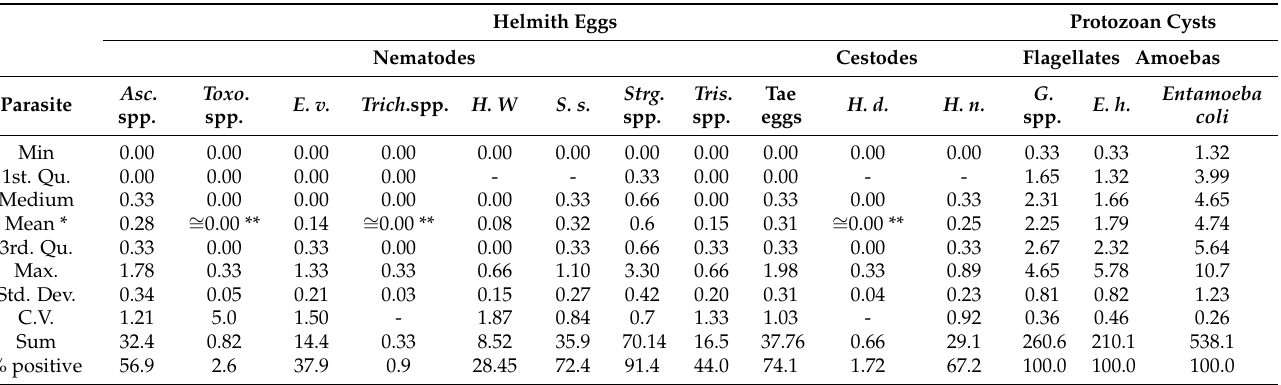
Table 3. Descriptive statistics of Helminth ova and protozoan cysts obtained in the dried sludge samples per 100 g DM (N = 116) for the 10 investigated WWTPs during 2013–2015.